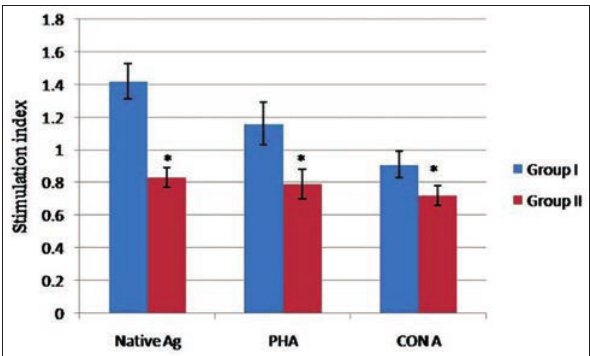
Figure-9: Mean ± standard error stimulation index values to compare cell-mediated immune response in both the two groups, *differ significantly (p<0.001) from Group I.